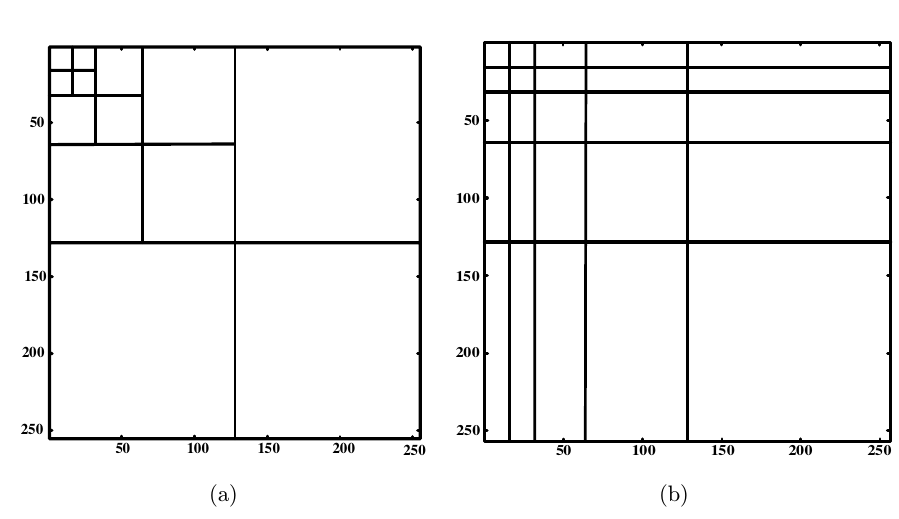
Fig. 1. Multiresolution 2D wavelet decomposition (4-levels). (a) Conventional 2D wavelet decomposition, (b) 2D Scale-mixing wavelet